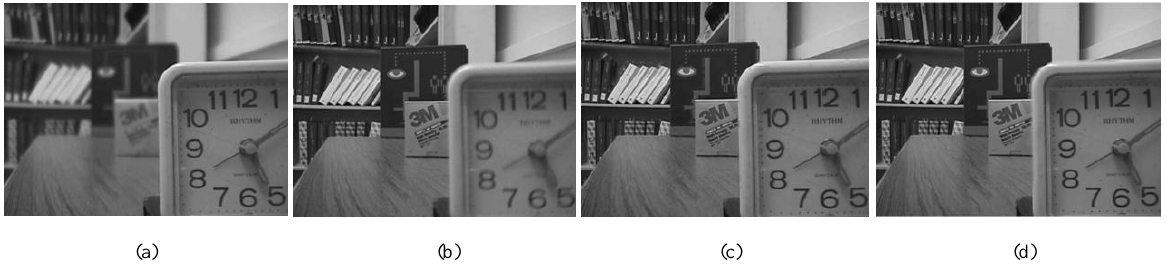
Figure 6. Source images “Disk” and fusion results. (a) First source image with focus on the right. (b) Second source image with focus on the left. (c) DCT+Eng_Corr (proposed). (d) DCT+Eng_Corr+RCV